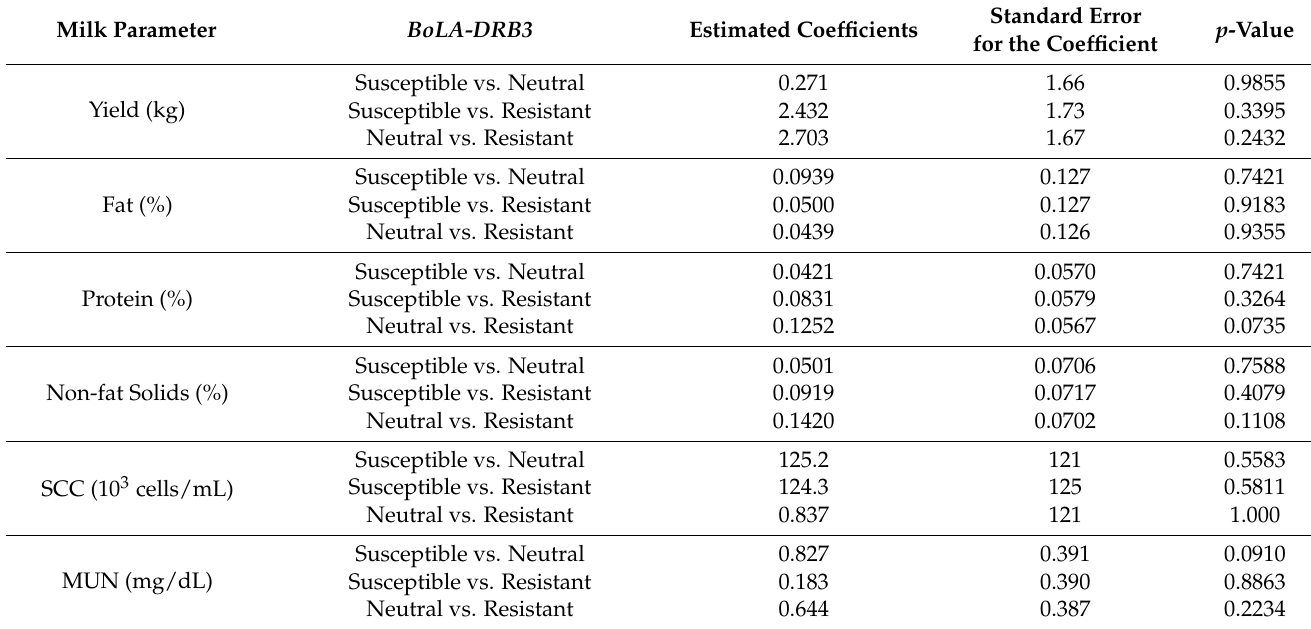
Table 2. Effects of BoLA-DRB3 on dairy cattle